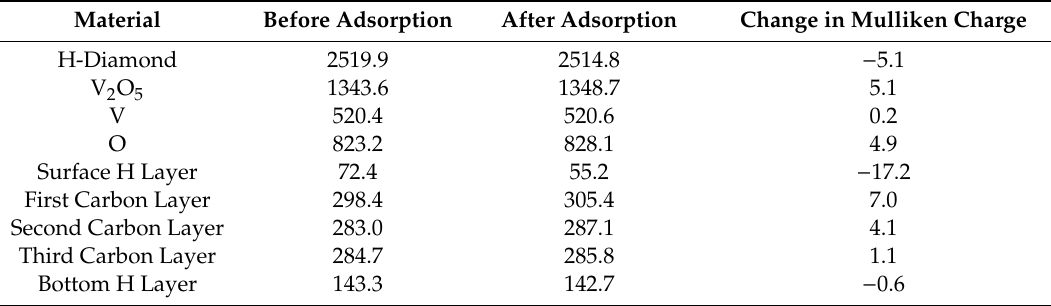
Figure 11. Side view of the V 2 O 5 :H-diamond interface structure showing the electron density differences. The purple regions represent electron accumulation and the green regions represent electron depletion (hole accumulation). The isosurface values are ±0.0025 Bohr − 3 . Table 3. The calculated Mulliken charges for the MoO3-doped diamond